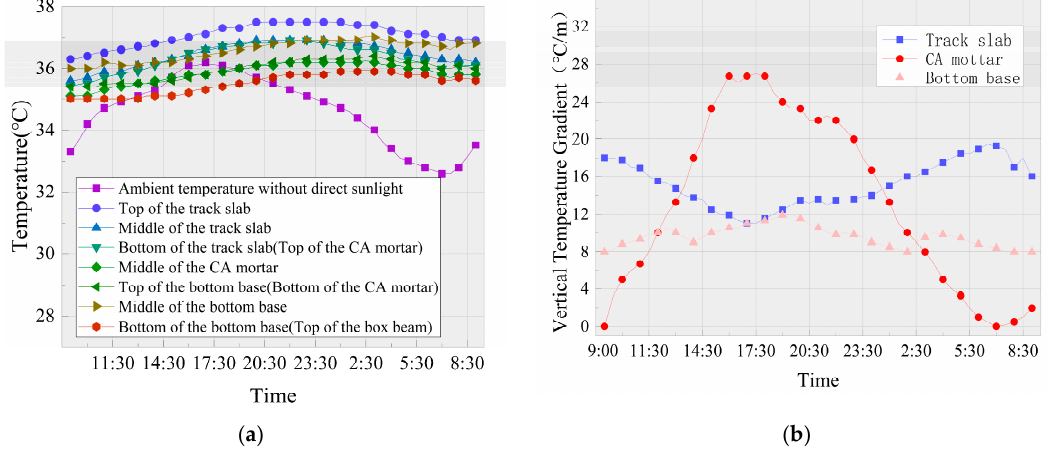
Figure 6. Temperature time history curve. ( a ) Temperature time history curve of the whole test process; ( b ) temperature gradient time history curve of the inter layer.